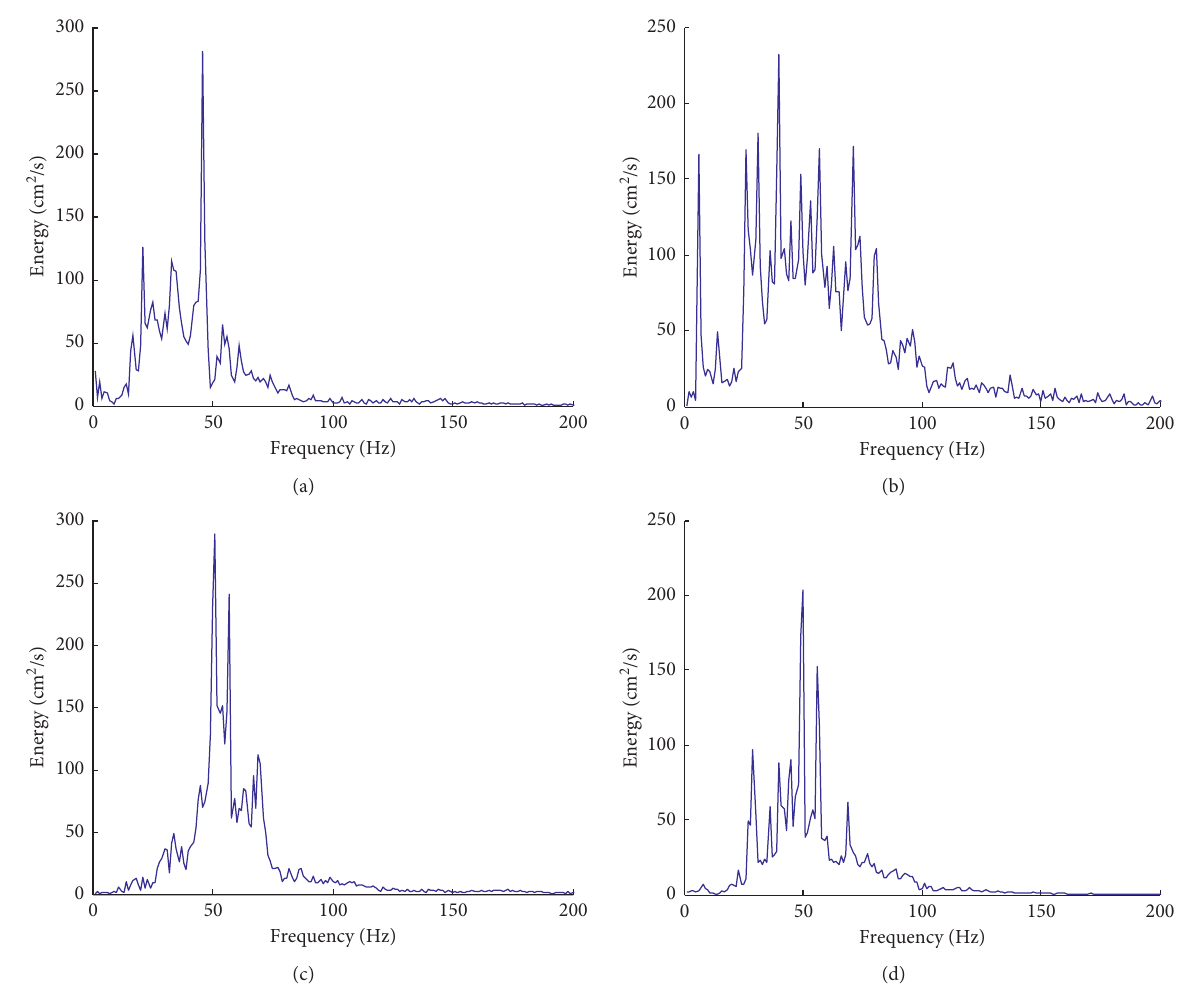
Figure 10: Signal marginal spectra. (a) Conventional charge structure. (b) Water interval charge at both ends. (c) Water interval charge at the orifice. (d) Water interval charge at the hole